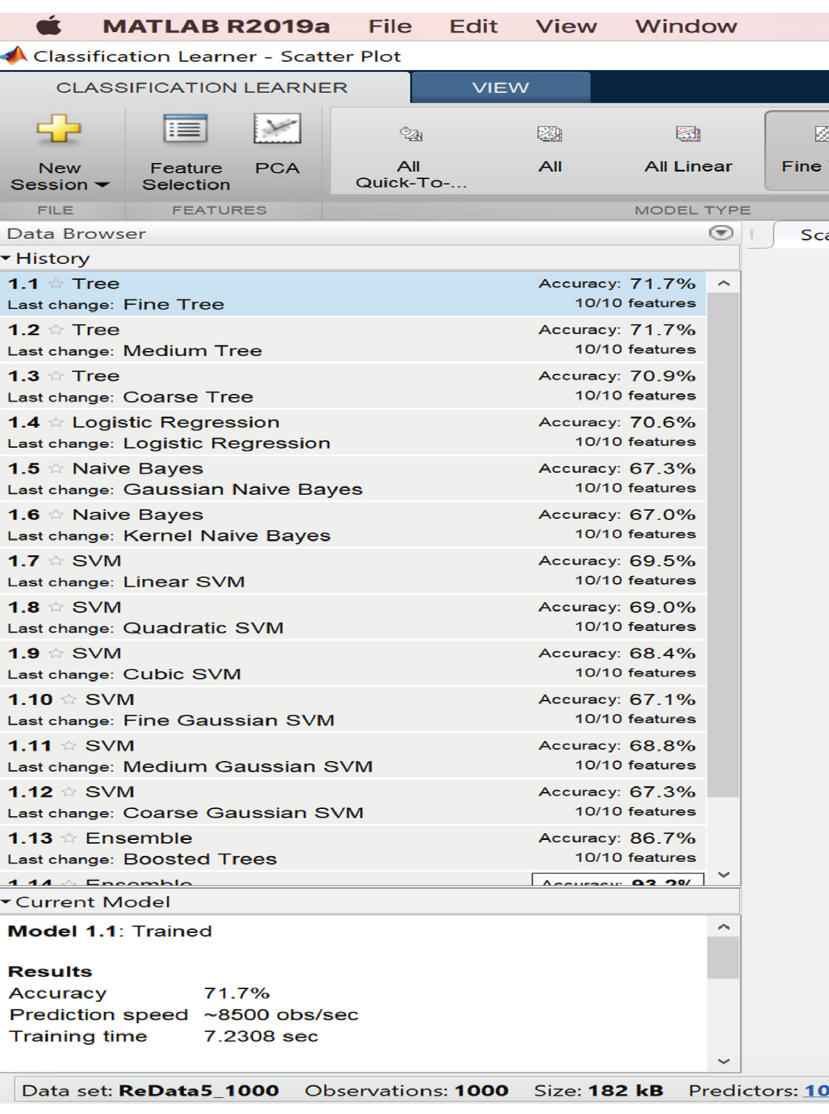
Figure 20: Algorithmic runs on the 1000-claim